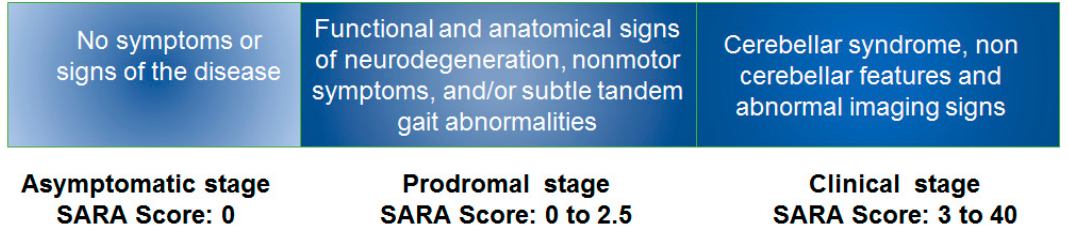
Figure 5. Natural history of the progression of the SCA2 cerebellar ataxia. SARA: Scale for the Assessment and Rating of Assessment and Rating of Ataxia.